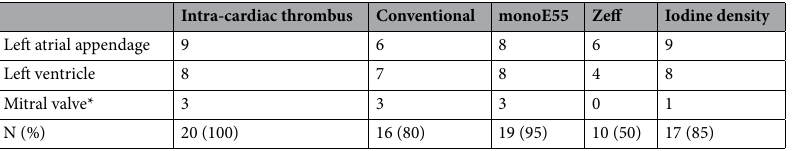
Table 2. Detection rate of intra-cardiac thrombi in conventional and spectral image reconstruction datasets. monoE55, virtual 55 keV monoenergetic; Zeff, z-effective. *All thrombi were found on prosthetic mitral valves.